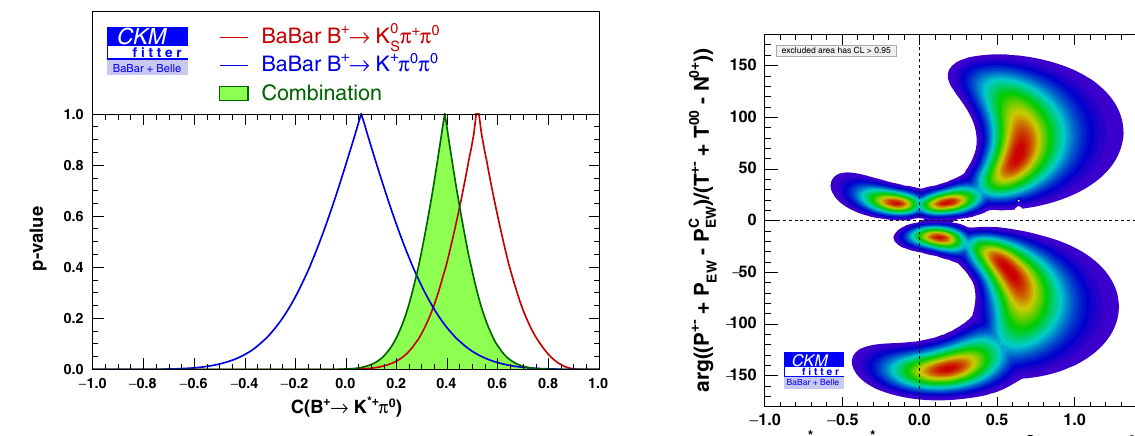
Fig. 5 Constraint on the direct CP asymmetry parameter C ( B + → K (cid:7) + π 0 ) = − A CP ( B + → K (cid:7) + π 0 ) from BaBar data on B + → π + π 0 ( red curve ), BaBar data on B + → K + π 0 π 0 ( blue curve ) K 0 S and the combination (g reen shaded curve ). The constraints are obtained using the observables described in the text